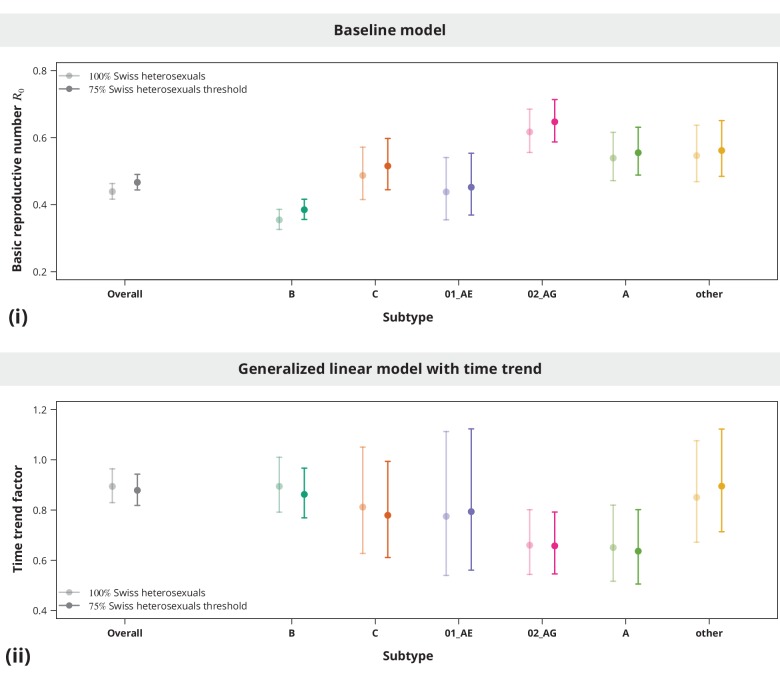
Sensitivity analysis regarding the transmission cluster definition.The upper panel (i) compares the estimated R0 with the original cluster definition (brighter lines) with the R0 estimated based on the relaxed cluster definition (darker lines) from the overall analysis (in gray) and subtype-stratified analyses (in colors). Similarly, the bottom panel (ii) shows the comparison between the estimated time trend factors obtained from the transmission chain sizes based on different cluster definition thresholds.